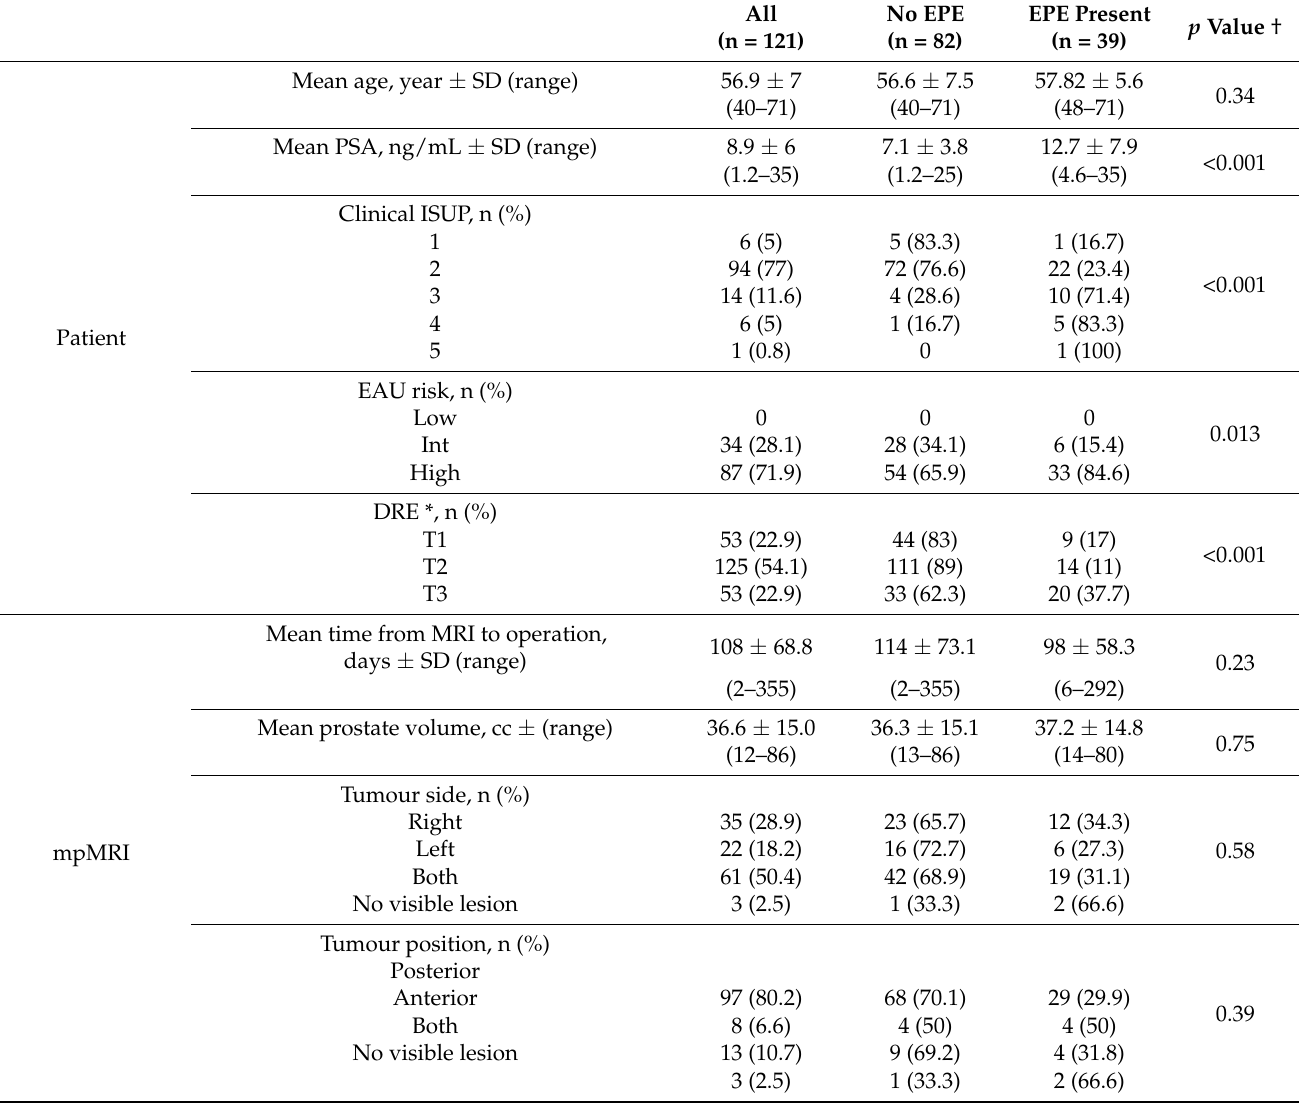
Table 1. Patient, radiological, and pathological characteristics of study cohort.